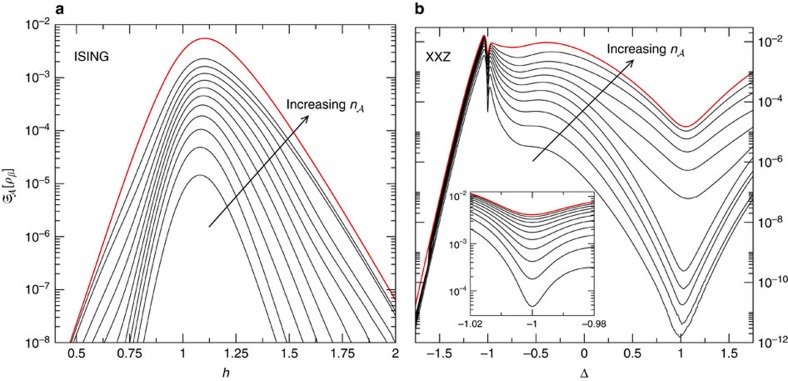
The LQTS in the Ising and the Heisenberg models at low temperature.We numerically computed the LQTS of equation (1) in the low-temperature limit for a chain with L=12 sites in the following two cases: (a) the Ising model as a function of the adimensional transverse field h; (b) the Heisenberg XXZ chain as a function of the anisotropy Δ. The uppermost (red) curve corresponds to the global quantum thermal susceptibility, that is the heat capacity. The other curves stand for different sizes  of the measured subsystem  of  ( increases along the direction of the arrow). The inset in b magnifies the data around Δ=−1. In the XXZ model, the LQTS with =1 can be proved to rigorously vanish. The inverse temperature has been fixed in both cases at β=9.